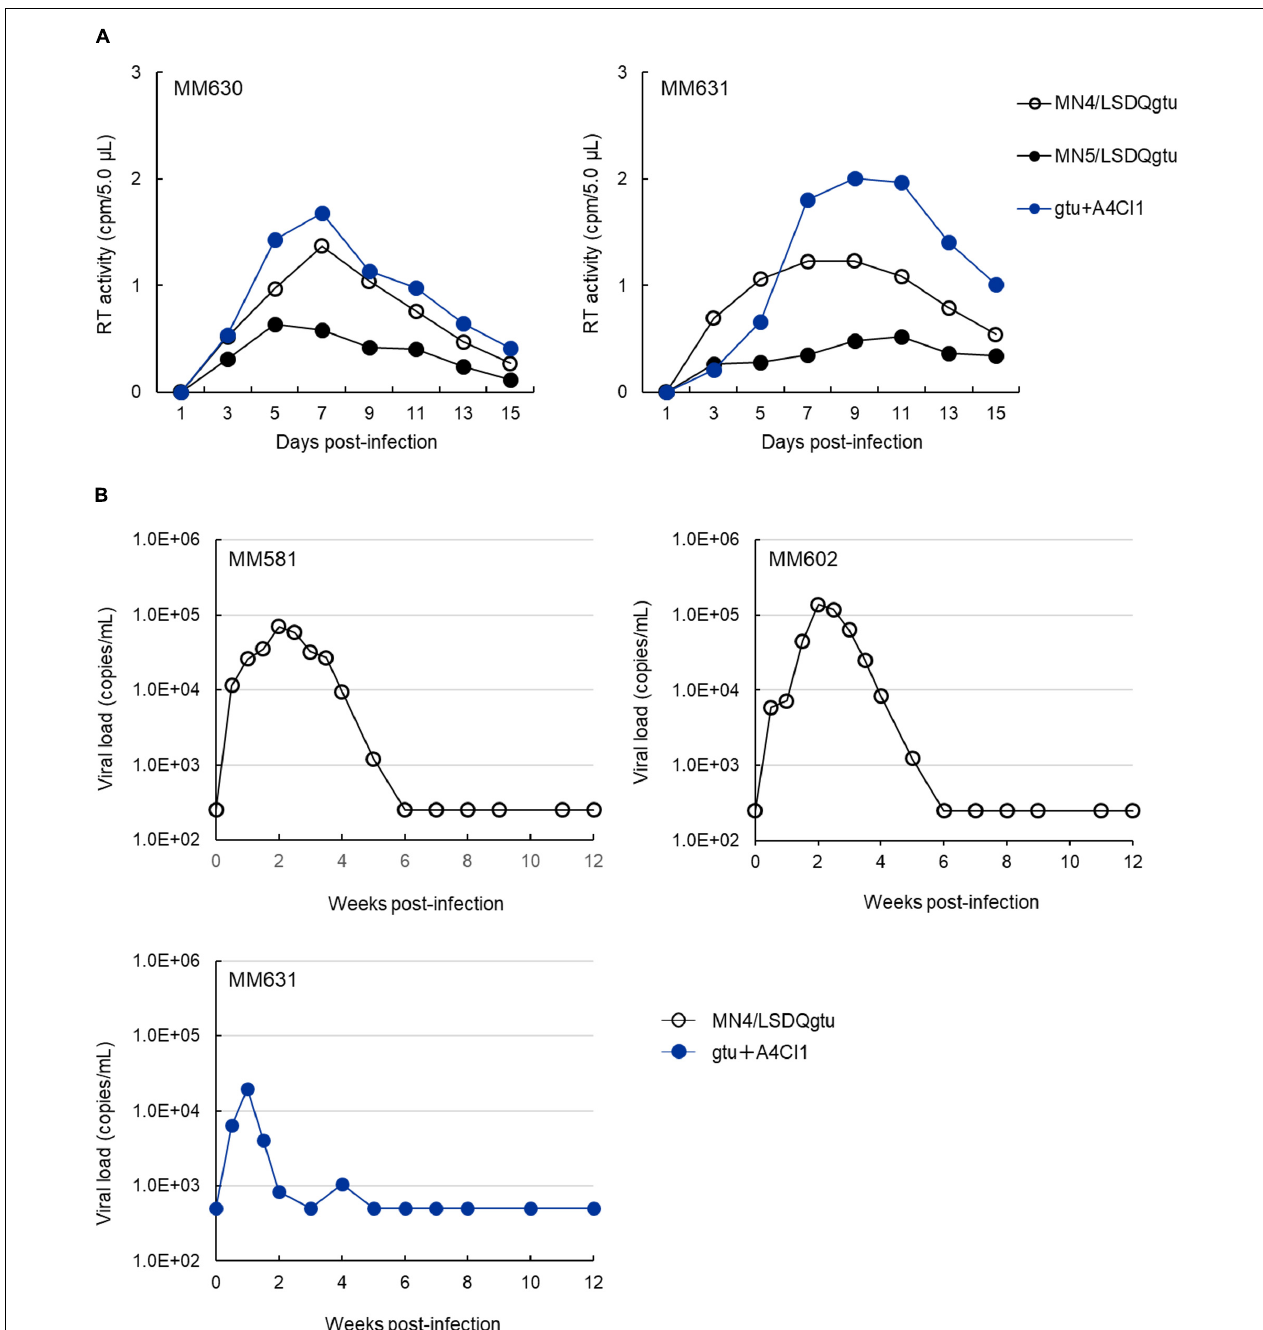
FIGURE 2 | Growth property of HIV-1rmt clones in rhesus PBMCs and individuals. (A) Viral replication kinetics in rhesus PBMCs infected with CXCR4-tropic MN4/LSDQgtu, CCR5-tropic MN5/LSDQgtu, or CCR5-tropic gtu + A4CI1. PBMCs were prepared from rhesus macaques MM630 and MM631, and spin-infected with cell-free viruses obtained from transfected 293T cells as previously described (Nomaguchi et al., 2013b, 2014). Cell numbers and input viral amounts used were 2.0 × 10 6 and 4.1 × 10 6 RT units, respectively. (B) Kinetics of plasma viral loads in rhesus macaques inoculated with CXCR4-tropic MN4/LSDQgtu or CCR5-tropic gtu + A4CI1. Rhesus macaques MM581, MM602, and MM631 were infected with cell-free viruses obtained from transfected 293T cells, and monitored for viral RNAs in plasma as previously described (Otsuki et al., 2014; Ishida et al., 2016). MM581 and MM602 were inoculated intravenously with 4.3 × 10 5 TCID 50 of MN4/LSDQgtu as determined in a macaque cell line HSC-F (Akari et al., 1999). MM631 was inoculated with gtu + A4CI1 intravenously (5.0 × 10 6 TCID 50 in HSC-F cells) and intraperitoneally (1.5 × 10 7 TCID 50 in HSC-F cells). Infection experiments (MM581/MM602 and MM631) were separately and independently conducted, and the detection limits for the MM581/MM602 and MM631 experiments were 250 and 500 copies/ml, respectively. The TRIM5 genotypes as analyzed by the previously described method (Wilson et al., 2008) for MM581, MM602, MM630, and MM631 are TRIM5 TFP / TFP ( Mamu-1/Mamu-3 ), TRIM5 TFP / TFP ( Mamu-3/Mamu-3 ), TRIM5 TFP / TFP ( Mamu-3/Mamu-3 ), and TRIM5 Q / Q ( Mamu-4/Mamu-4 ), respectively.